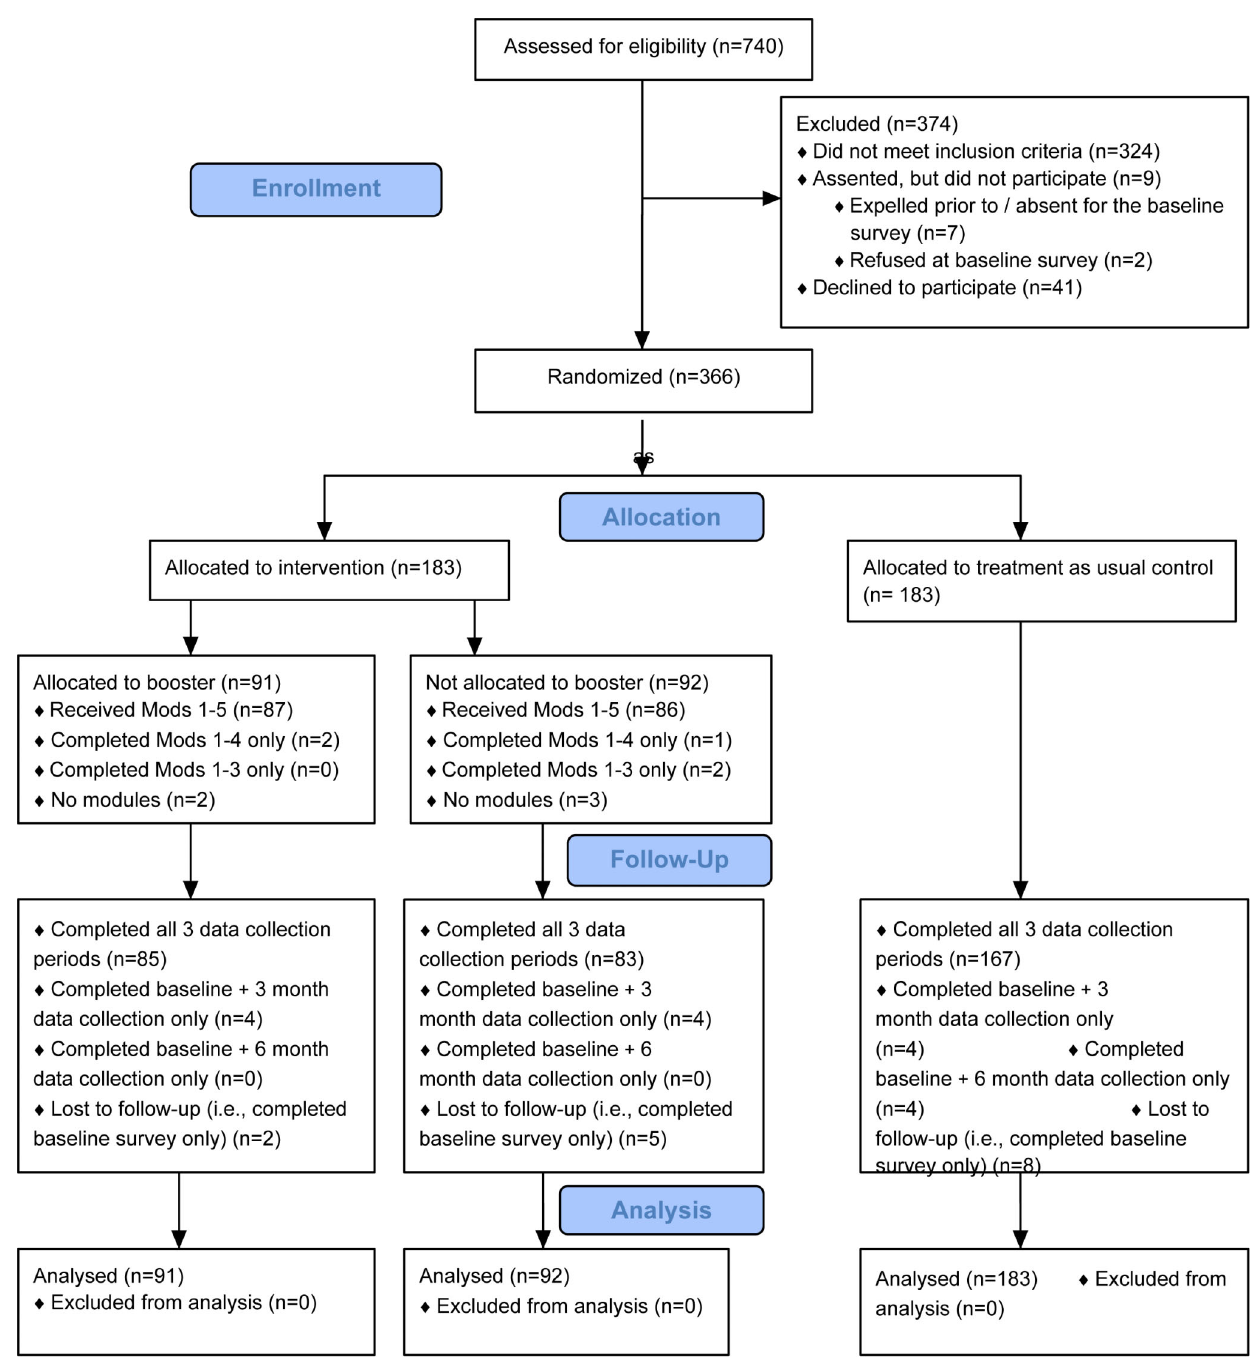
Figure 1. CyberSenga Randomized Controlled Trial Consort Diagram.